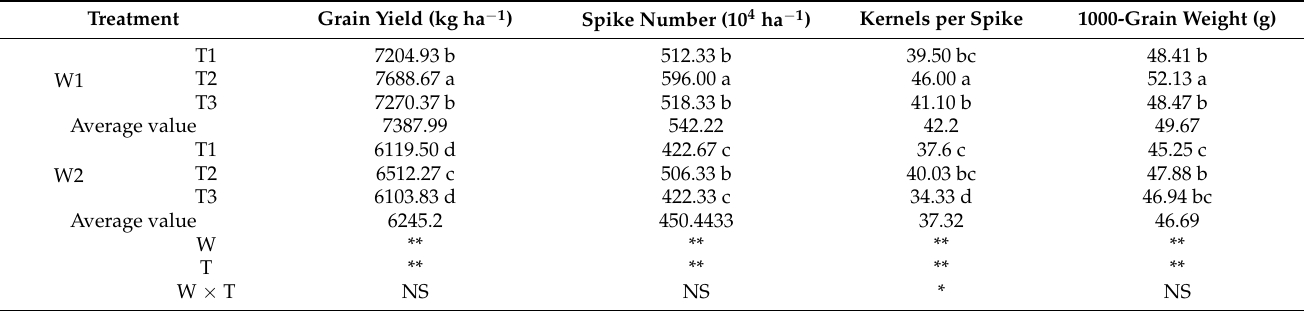
Table 3. Effects of different treatments on grain yield and its components of winter wheat.